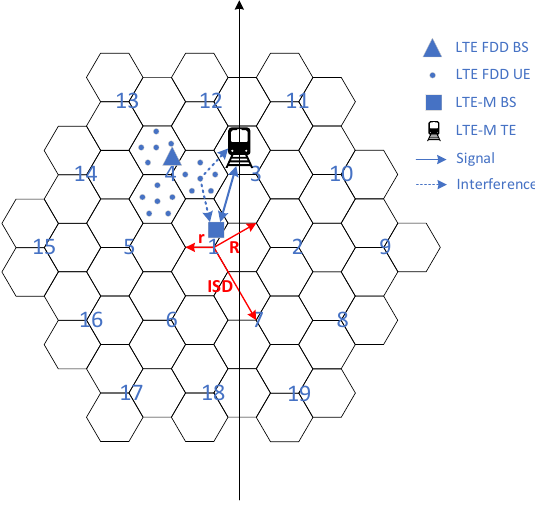
Figure 9. Interference scenario network topology. Offset D indicates the distance between the interferer system and the victim system.